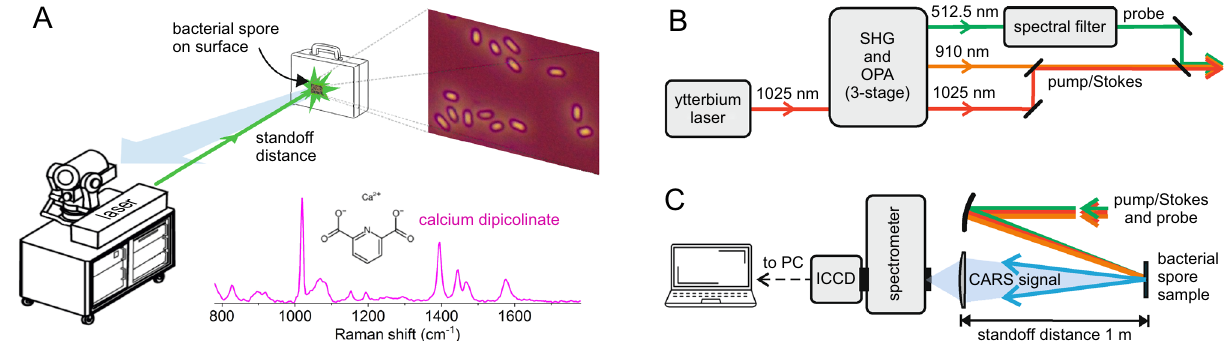
Figure 1. ( A ) Standoff detection of bacterial spores by a portable laser system; the inset shows the spontaneous Raman spectrum of calcium dipicolinate, which is the Raman marker for detection of bacterial spores. Layout of the system for ( B ) generation of pump, Stokes, and probe laser pulses and ( C ) excitation/collection of backscattering CARS signal in standoff